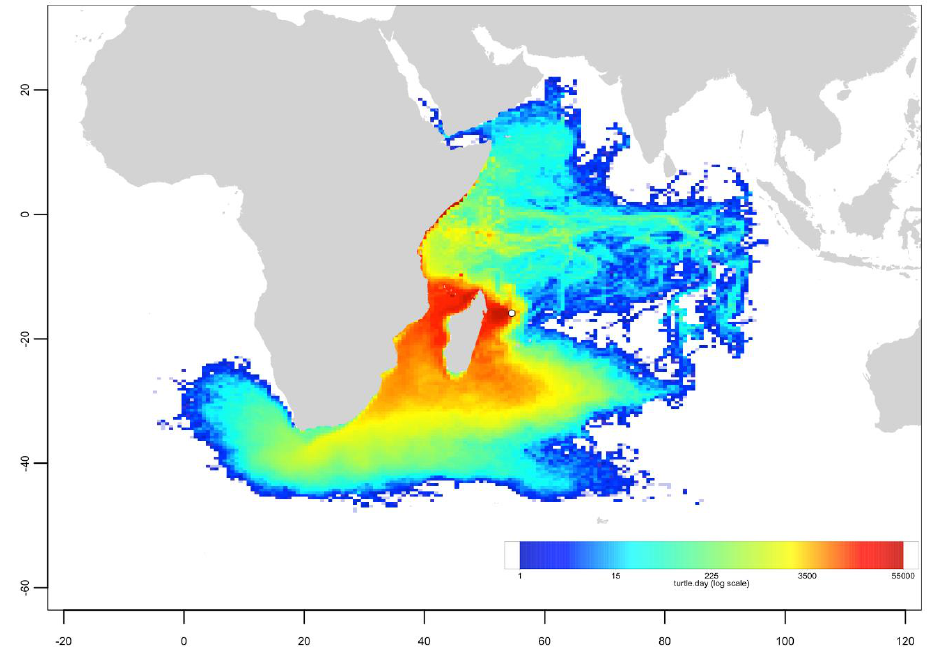
Figure A8. Tromelin dispersal map. One-year long trajectories of 10,000 particles released from a 0.25° × 0.25° areas located about 40 km off the main nesting beaches of Tromelin (with circle) from 2002 to 2006 (for a total of 50,000 particles). The color indicates the density of particles in number of turtles per day (log scale).